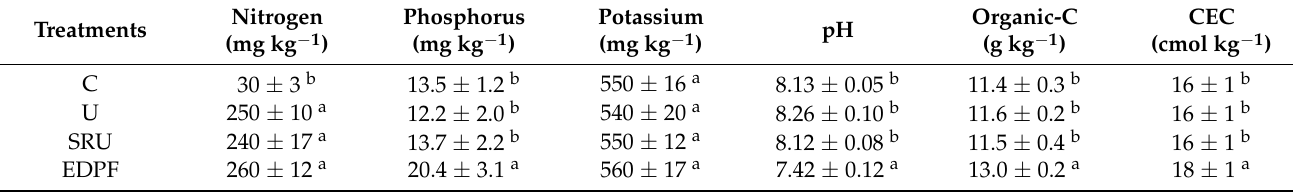
Table 4. Effect of nitrogen forms on nutrients availability and some chemical properties of soil. Treatments